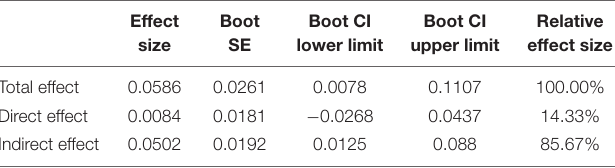
TABLE 4 | Total, direct and indirect effects among the